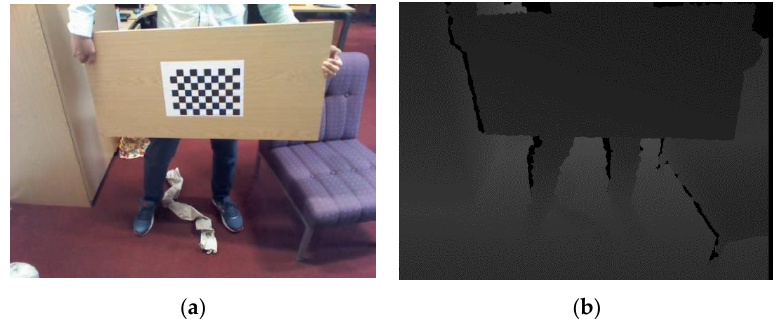
Figure 9. One of the test data sets . ( a ) the checkerboard image under Kinect view; ( b ) the corresponding depth image.